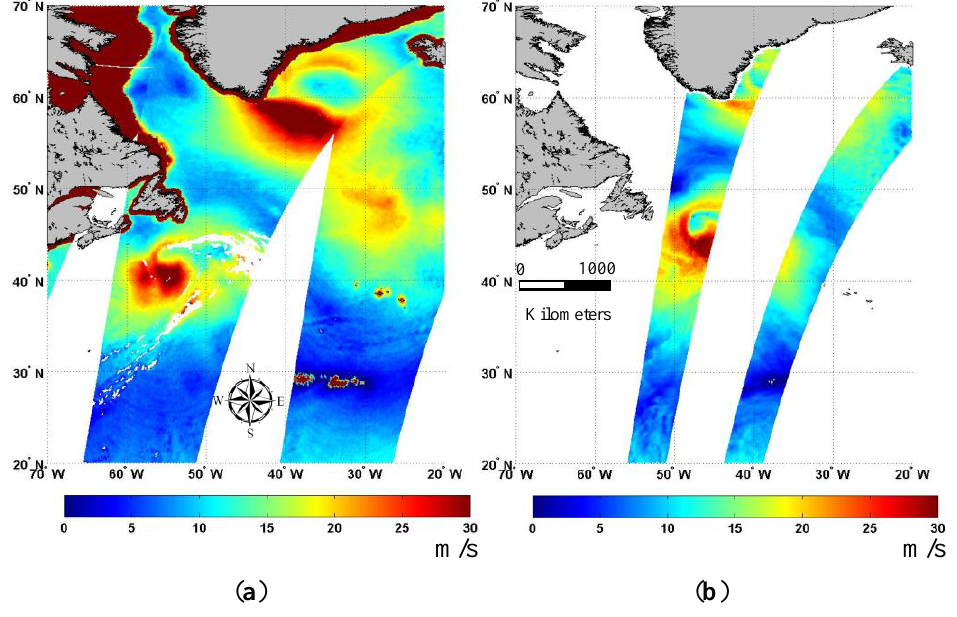
Figure 8. Sea surface wind speed fields for the two extratropical cyclones over the North Atlantic on 13 February 2011: ( a ) AMSR-E retrieved WS at  4–7 UTC; ( b ) Metop-A ASCAT Level 2 Operational and Optimized Coastal Ocean Near-Real-Time ocean wind vector product at  12:30